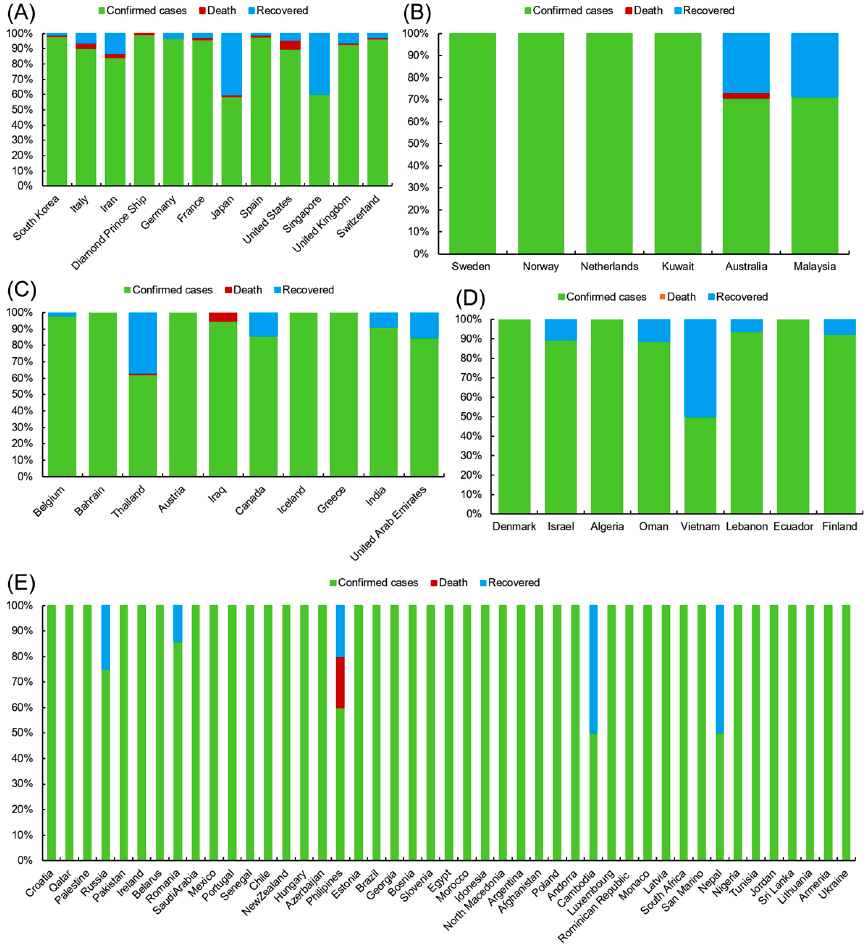
Fig. 1. Recent stats on global emergence and worldwide confirmed 2019-nCoV cases in different countries. The data is distributed based on the confirmed cases range, i.e., (A) more than 100 confirmed 2019-nCoV cases, (B) confirmed 2019-nCoV cases in the range between 51-100, (C) confirmed 2019-nCoV instances in the range between 26-50, (D) confirmed 2019-nCoV cases in the range between 11-25, and (E) confirmed 2019-nCoV cases in the range between 1-10. Data Source: IFENG News. Available online at the link: https://jobtube.cn/ wv/?from=singlemessage&isappinstalled=0 [Last accessed date: 6 March